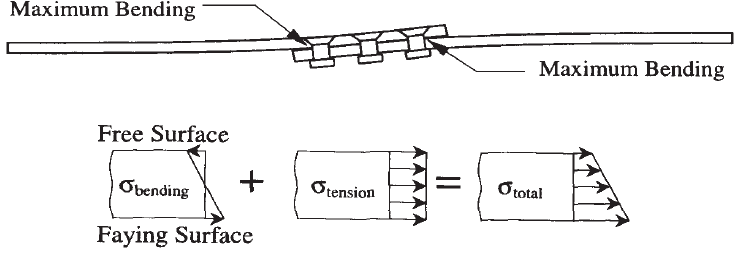
Figure 4: Secondary bending